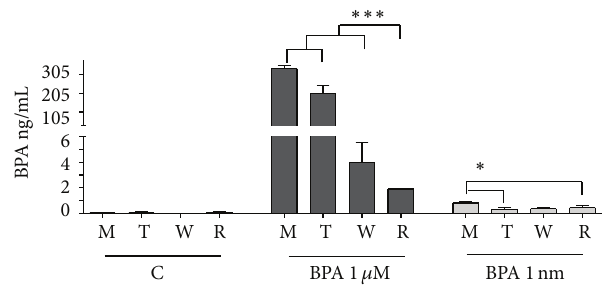
Figure 6: Concentration of free BPA in the culture media and cell lysates of decidualized stromal cells, detected by GC-MS. C: exposure media containing vehicle (0.1% EtOH); BPA 1 𝜇 M and BPA 1nM: exposure media containing BPA 1 𝜇 M or BPA 1 nM; M: media before exposure to the cells; T: media incubated for 24 h with the cells; W: washing media incubated for 24 h with cells previously exposed to vehicle (group C) or to BPA (groups BPA); R: cell lysates in RIPA buffer, after incubation with washing medium. Values are expressed in ng/mL ± SD of free BPA of 𝑛 = 3 separate experiments ( ∗ 𝑃 < 0.05 versus M; ∗∗∗ 𝑃 < 0.001 versus